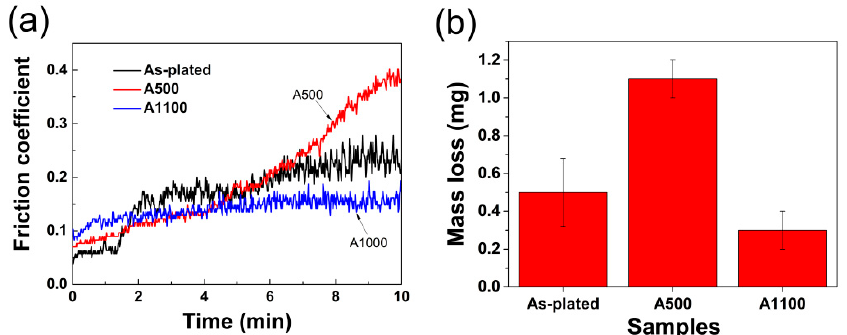
Figure 8. Friction coefficient plotted as a function of sliding friction time ( a ) and weight loss ( b ) of various samples.